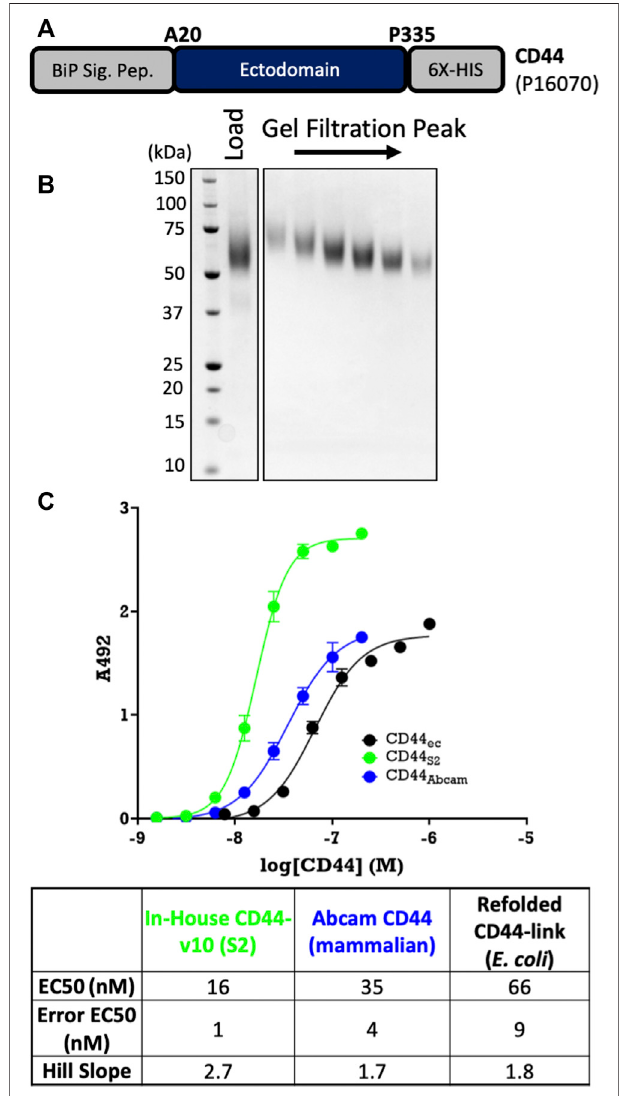
FIGURE5| Large-scalepuri fi cationofCD44. (A) Constructdesignusing pExpreS 2 -1-C3-10H-SIII. (B) CD44ispureandmonodispersesafterSEC. (C) Binding assay con fi rms that S2-derived CD44 binds to its ligand hyaluronic acid (HA) with similar af fi nity as E. coli – or mammalian-derived CD44. Data are presented from a single biological replicate and were fi t via four component (variable slope) nonlinear regression using GraphPad Prism.